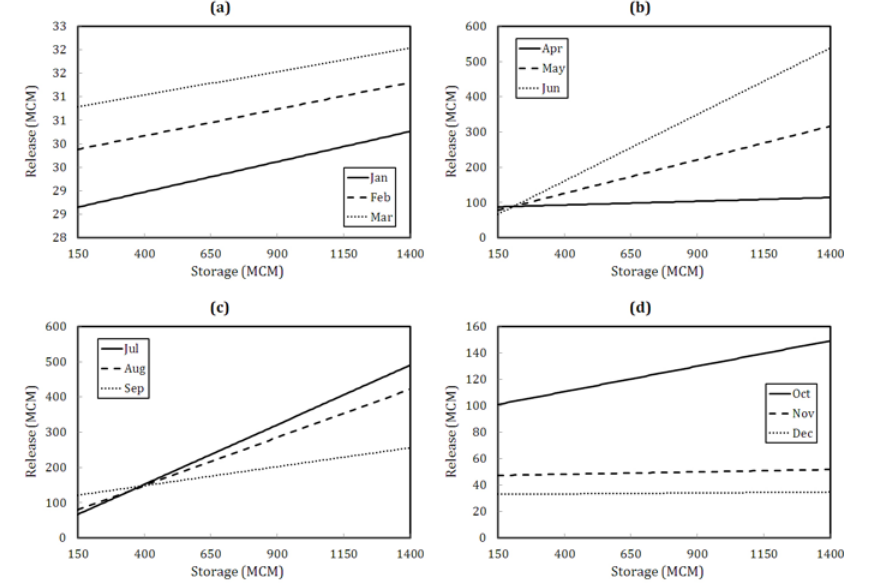
Fig 7. The operating policy resulting from the collocation solution, applying Chebychev approximation function.